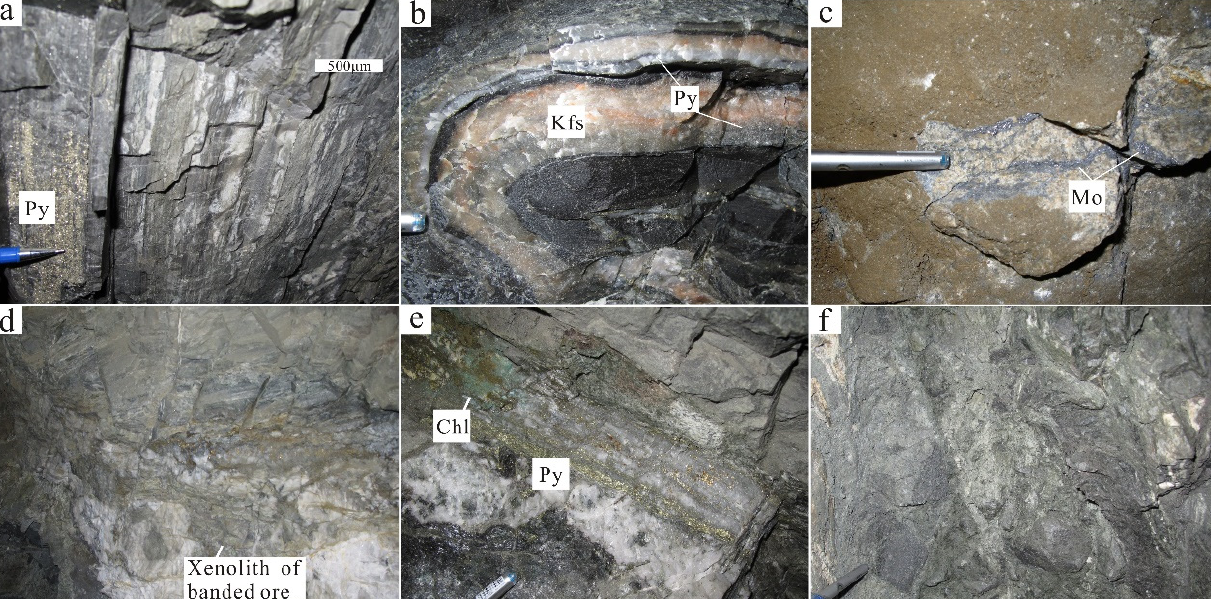
Figure 4. Ore and alteration styles in the Jiancaowan Au deposit. ( a ) Banded quartz–sulfide vein; ( b ) syn-deformational quartz–K-feldspar–sulfide vein; ( c ) porphyry-type mineralization; ( d ) early banded ore captured by a later quartz vein; ( e ) silicification + chloritization + disseminated metal sulfidation zone; ( f ) chloritization + epidotization zone. Kfs, K-feldspar; Chl, chlorite; Py, pyrite.